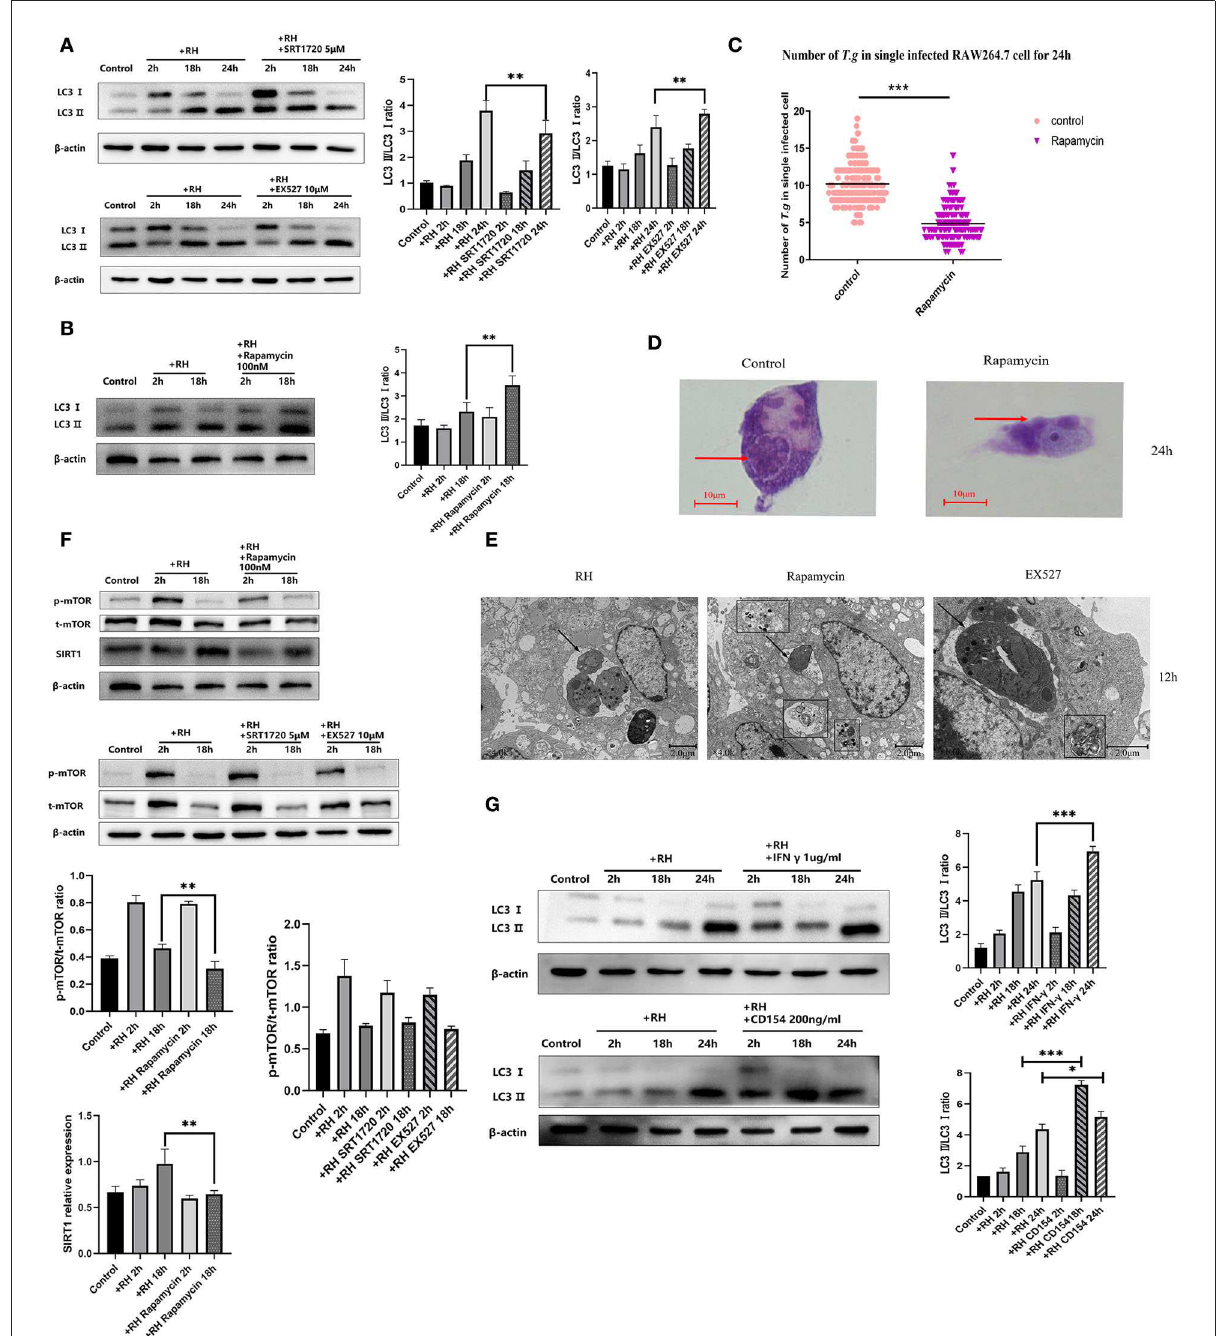
FIGURE6 Autophagy regulation by Sirtuin 1 (SIRT1) and interferon gamma (IFN- γ ) or CD154 at different time points. RAW 264.7 macrophages were either infected with RH tachyzoites at a ratio of 5:1 (parasite/host cell) for 2h or left in the culture plate without infection, followed by incubation with SRT1720 (5 µ M), EX527 (10 µ M), or rapamycin (100nM) for 2, 18, or 24h before collection of the cell lysates or followed by incubation with rapamycin (100nM) for 24h for light microscopy or 12h before transmission electron microscopy (TEM). We adjusted the protein concentration of each group of samples to be consistent and then carried out the experiment. Anti-LC3 I/LC3 II antibody, anti-phospho-mTOR (mechanistic target of rapamycin kinase) antibody, anti-mTOR, and anti-beta-Actin antibody were used at a 1:1,000 dilution. (A) The LC3 II/LC3 I ratio in the Toxoplasma gondii infection group increased over time compared to that for the negative control. Infected macrophages treated with SRT1720 showed a downregulation of LC3II/LC3 I at 2, 18, and 24h compared to that for the T. gondii infection group. Infected macrophages treated with EX527 showed an upregulation of LC3II/LC3 I at 2, 18, and 24h compared to that for the T. gondii infection group. (B) Infected macrophages treated with rapamycin showed an upregulation of LC3 II/LC3 I ratio at 2 and 18h compared to that for the T. gondii infection group. (C) A scattered distribution chart showing the means of the intracellular tachyzoite counts. Values represent actual numbers